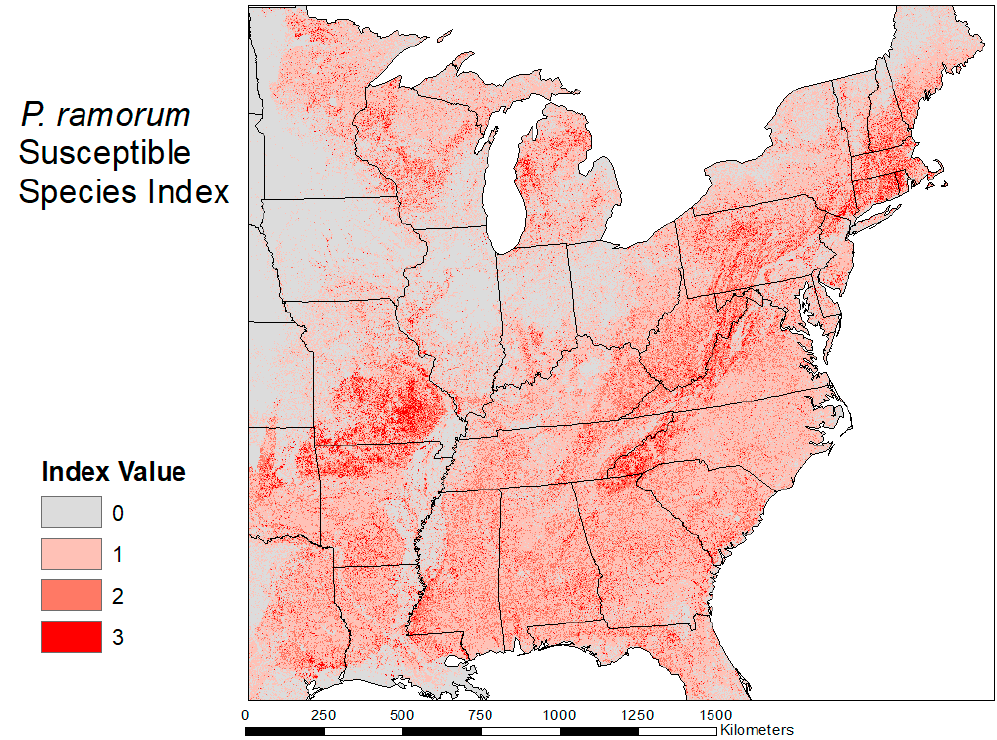
Figure 3. The index based on BA of tree species that can develop Sudden Oak Death (SOD). Resolution: 250 m.